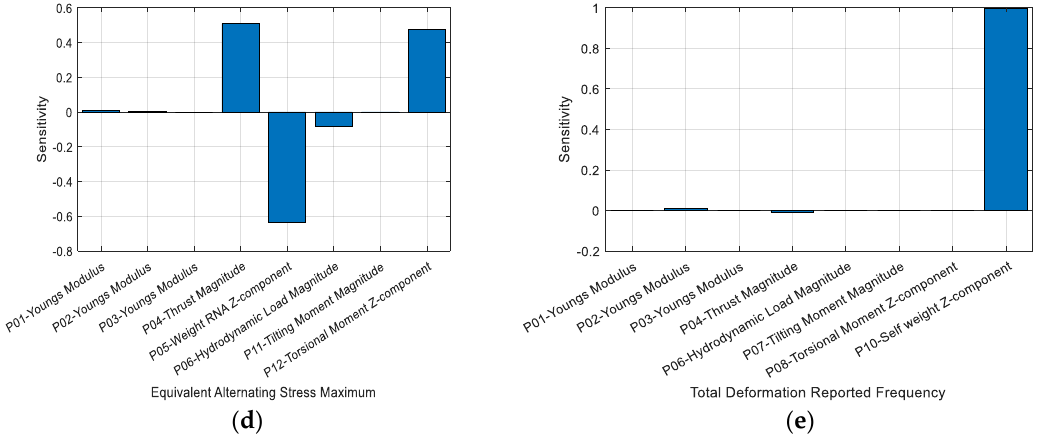
Figure 12. Global sensitivity chart: ( a ) stress design constraint (ULS); ( b ) deformation design constraint (SLS); ( c ) fatigue design constraint; ( d ) buckling constraint (ULS); ( e ) vibration constraint (SLS).